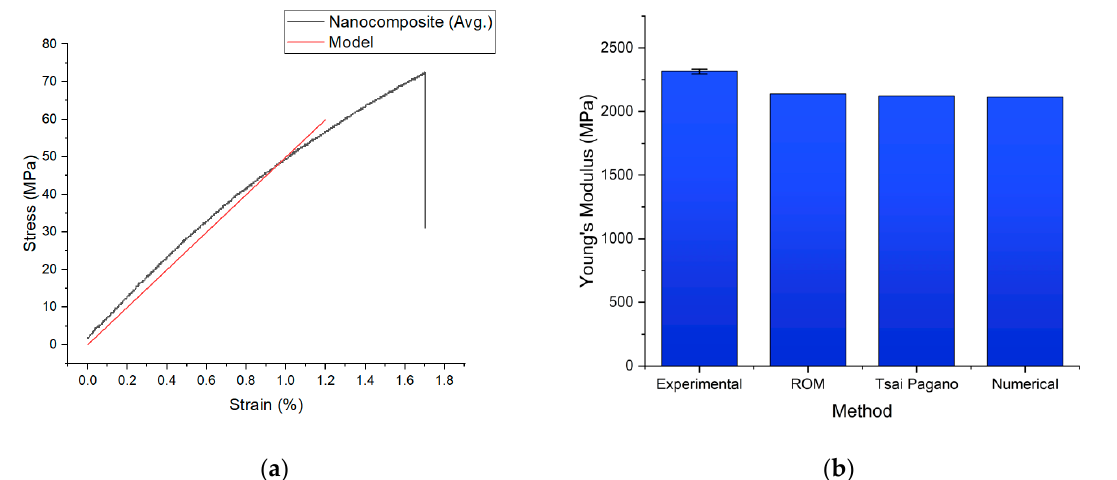
Figure 8. Data comparison for the nanocomposites. ( a ) Experimental and numerical simulation stress–strain graph; ( b ) comparison of the Young’s modulus.